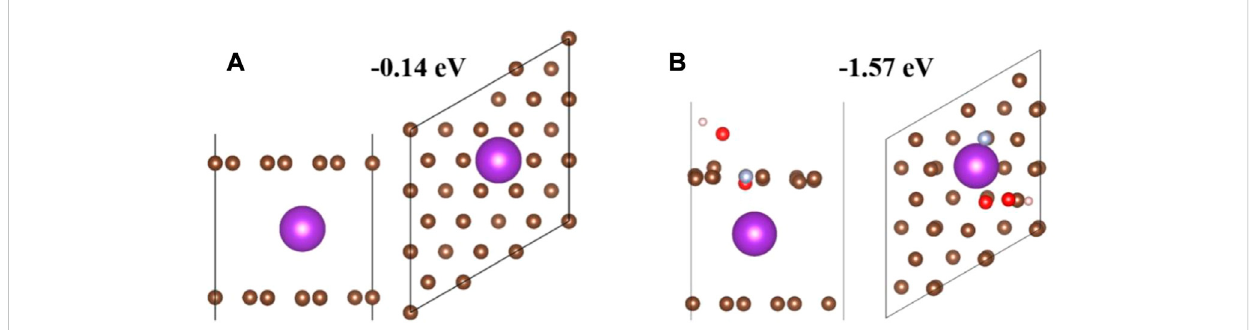
FIGURE 9 Theoretical simulation of K adsorption in different structures. Side and top views of single K atoms adsorbed on (A) hard carbon (HC) and (B) O/OH/ pyrrole N co-doped HC. The purple balls represent potassium atoms, the gray-blue balls represent nitrogen atoms, the brown balls represent carbon atoms, the red balls represent oxygen atoms, and the white balls represent hydrogen atoms (Yang, et al., 2021).